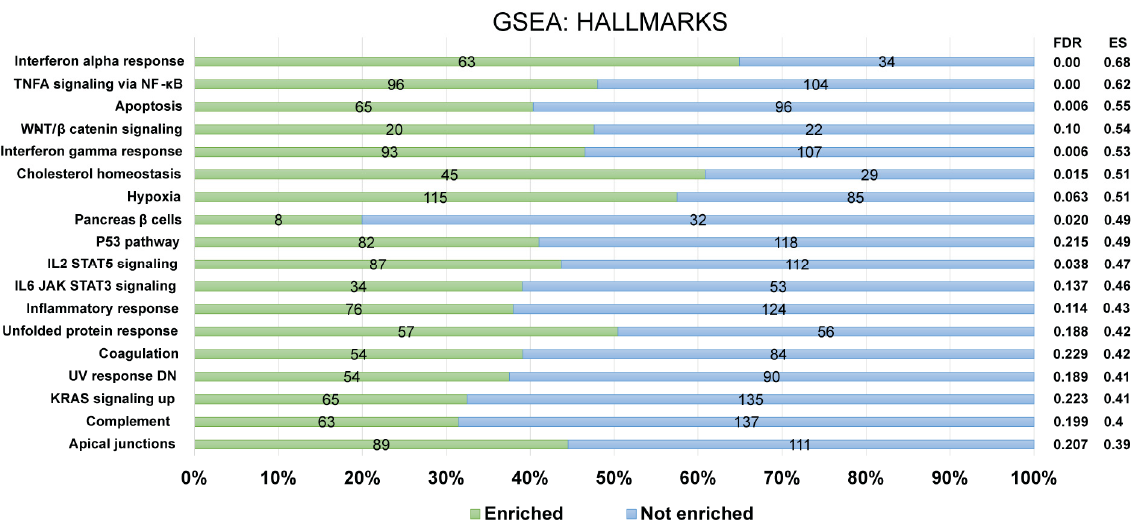
Figure 7. Identification of enriched biological pathways modulated by FOXP3 Δ 2 Δ 7 exogenous expression. Enrichment analysis from the Hallmark gene set collection was assessed by GSEA software. The left panel depicts the standard names of the statistically significant pathways, and the right panel shows the false discovery rate (FDR) and enrichment score (ES) values. The numerals at the bar plot indicate the number of enriched (green) and not enriched (blue) genes within each pathway. FDR < 0.25 was established as a selection criterion. A percentage scale is shown at the bottom for better visualization.